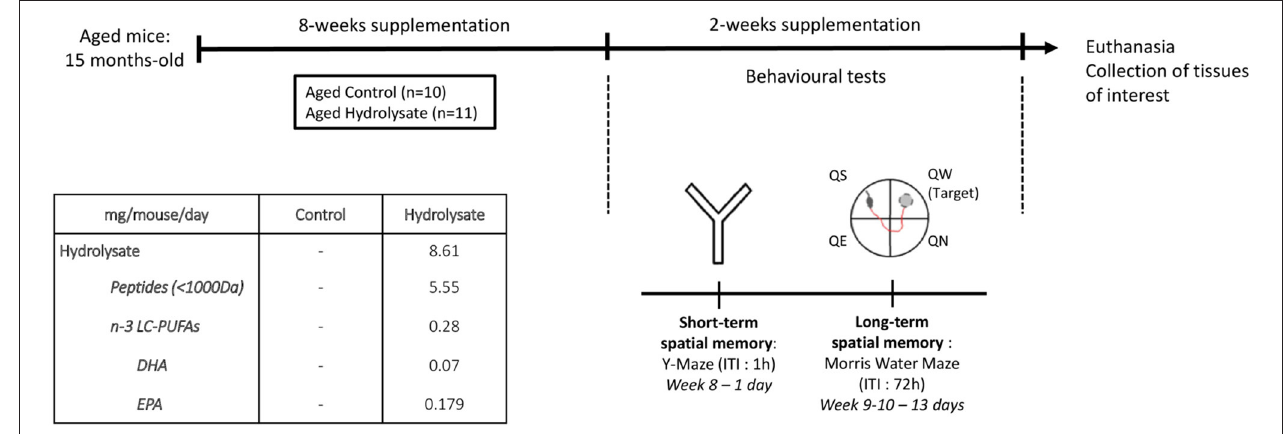
FIGURE 1 | Experimental design. Aged mice (15 months) were fed with the control diet or with the hydrolysate-enriched diet for 8 weeks. Behavioral tests were performed during the next 2 weeks. Total supplementation duration was 10 weeks. DHA, docosahexaenoic acid; EPA, eicosapentaenoic acid; ITI, inter-trial interval; LC-PUFAs, long chain polyunsaturated fatty acids; QE, quadrant east, QN, quadrant north; QS, quadrant south; QW, quadrant